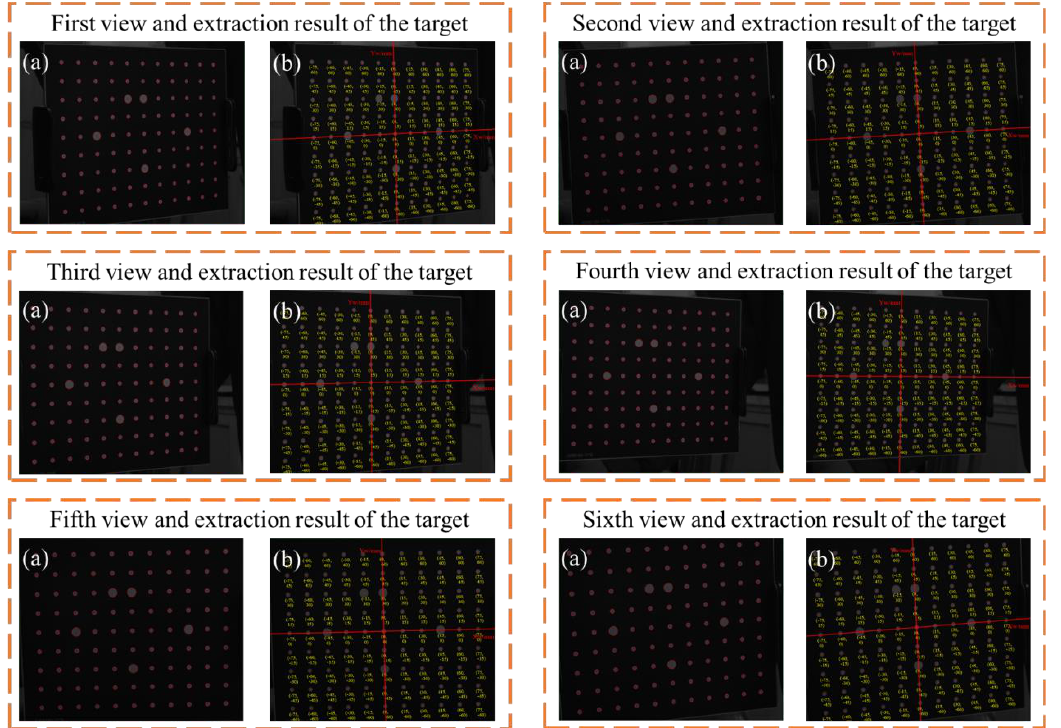
Figure 12. Different pose views and extraction results. ( a ) Ellipse fitting results of the different views. ( b ) Extracted feature centers and topological ordering results of the different views.